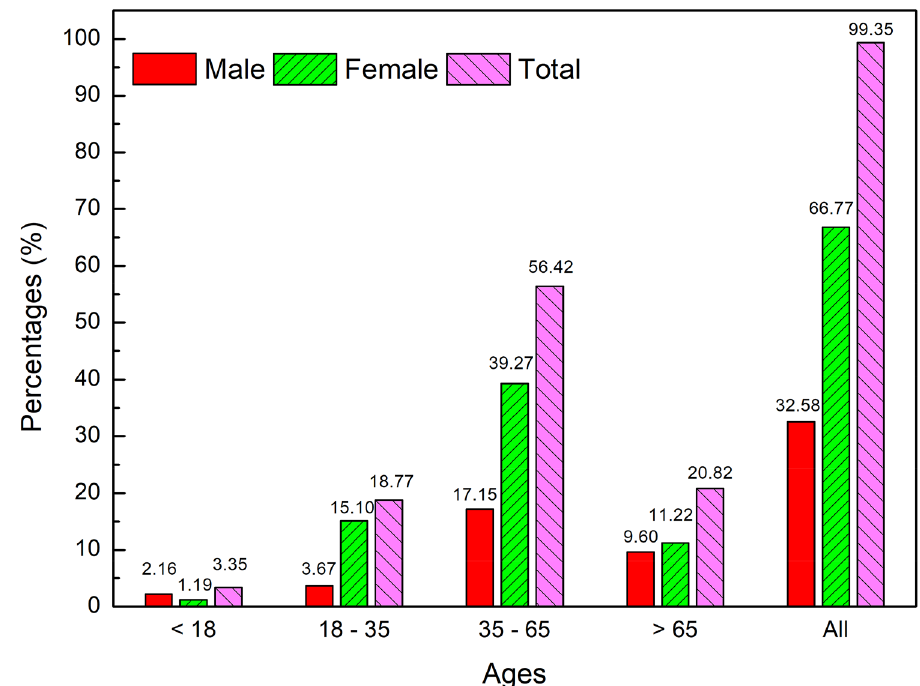
Figure 1. Distributions of age and sex in the 1028 ADR reports involving single herbs, herbal formulae and folk herbals analyzed from the TADRRS-HM (1998–2016).